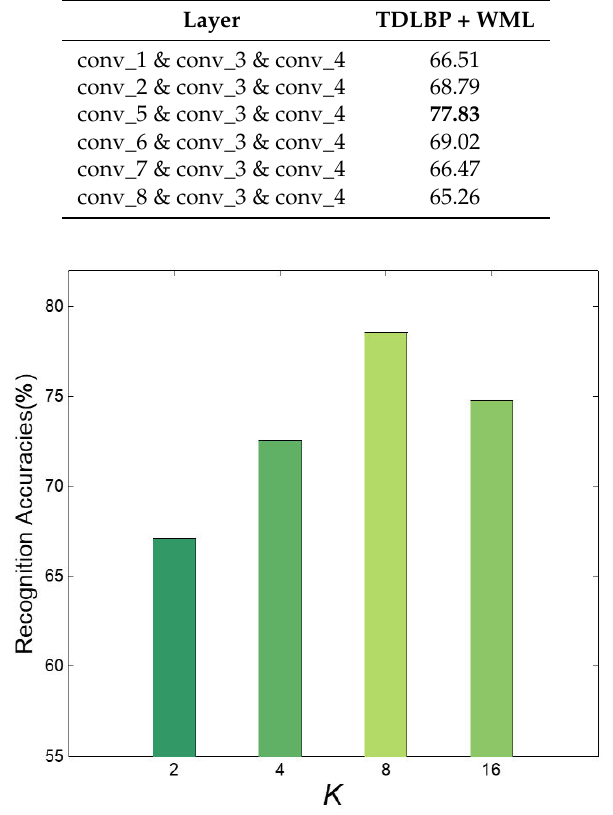
Figure 6. Recognition accuracies achieved by TDLBP + WML with varied numbers of K